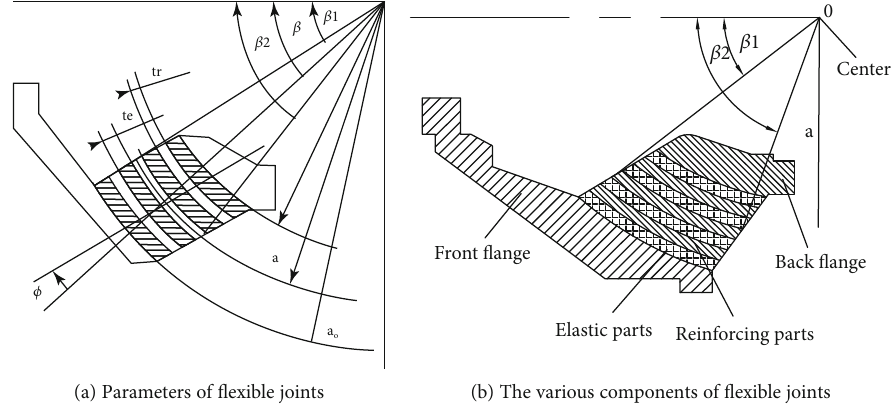
Figure 4: Flexible joint